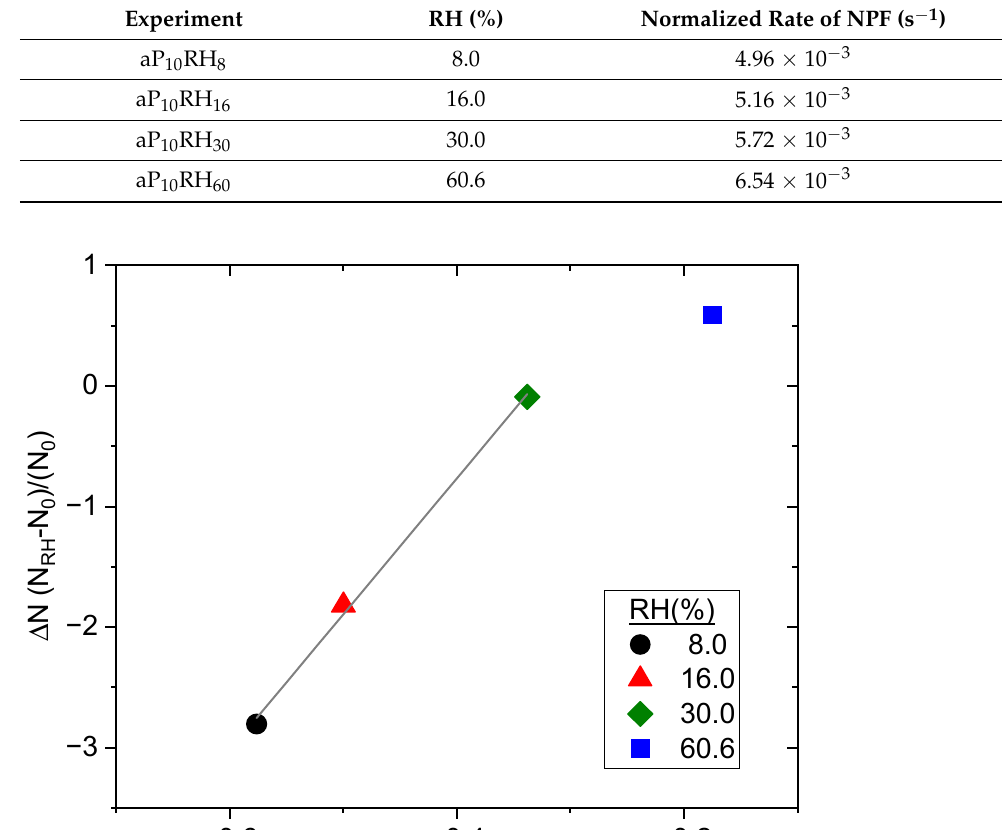
Table 4. Rate of NPF results corresponding to particle genesis at increasing levels of RH. Rate of particle formation (cm − 3 s − 1 ) was normalized for each RH for comparison.